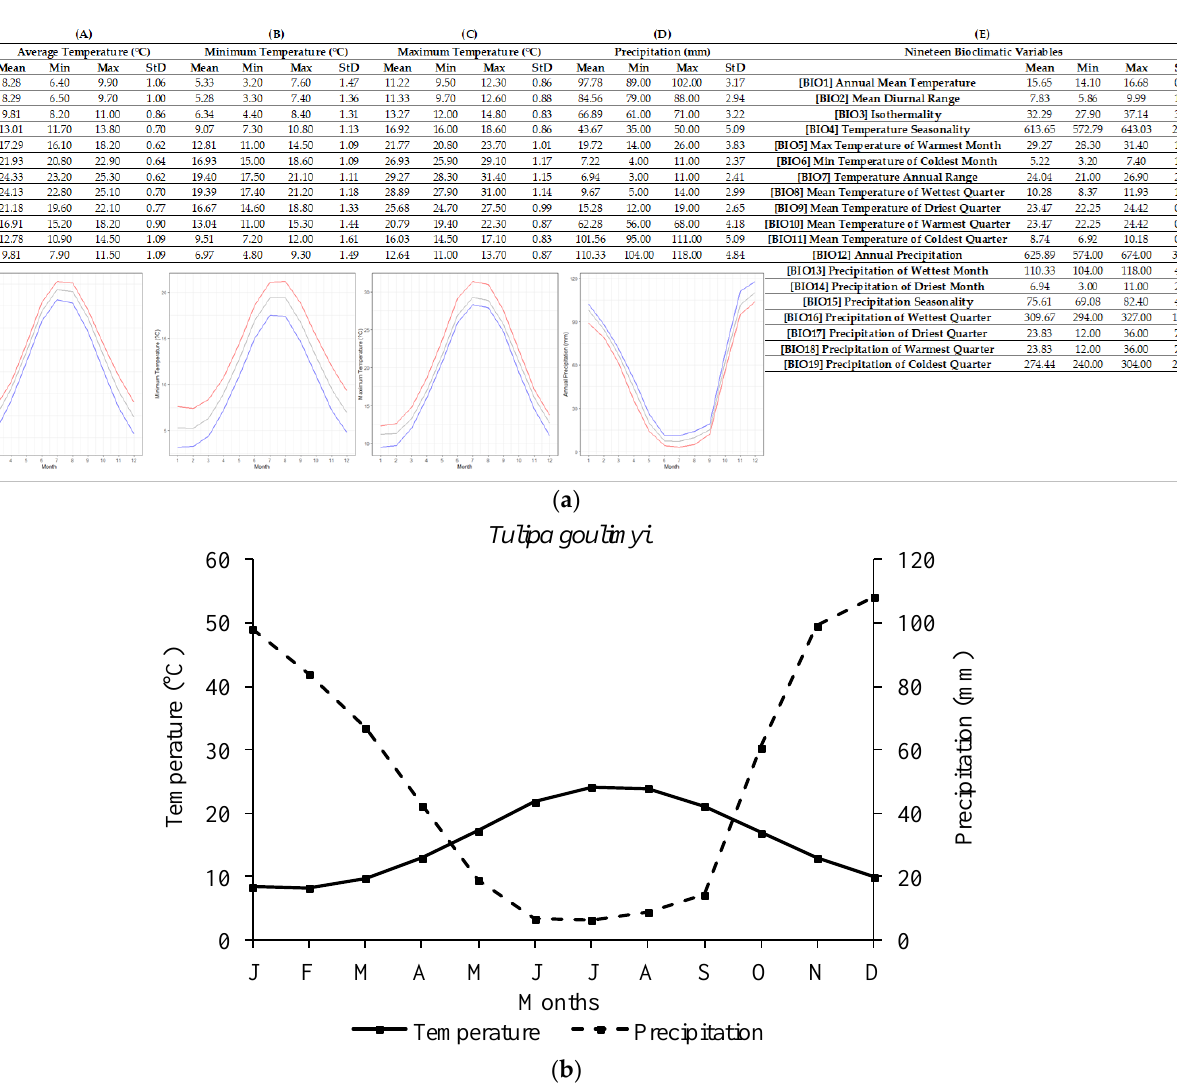
Figure 5. R-derived ecological profile ( a ) and Walter–Lieth climate diagram ( b ) of Tulipa goulimyi based on 15 Greek localities of high accuracy ( n = 15). For ( A – E ), minimum, maximum, and average values and standard deviations are represented in different columns. Line graphs ( A – C ) illustrate the minimum (blue), the maximum (red), and the mean (grey) monthly temperature ( ◦ C) and the line graph ( D ) illustrates the minimum (red), maximum (blue), and mean (grey) monthly precipitation (mm). ( A ) shows the minimum temperature in each month ( ◦ C), ( B ) shows the maximum temperature in each month ( ◦ C), ( C ) shows the average temperatures per month ( ◦ C), ( D ) shows the precipitation in each month (mm), and ( E ) shows the values for each of the 19 bioclimatic